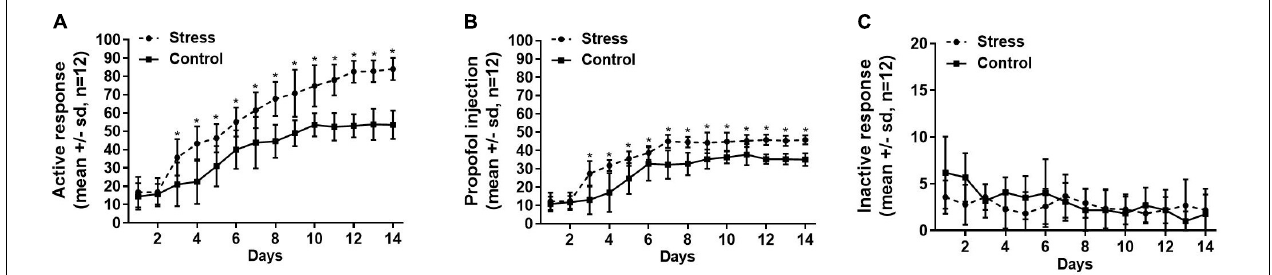
FIGURE 1 | The numbers of active nose-poke responses (A) , propofol infusions (B) , and inactive nose-poke responses (C) were compared between the stress group (with tail clip pretreatment) and the control group (without tail clip pretreatment) by using the two-way ANOVA of repeated measures, showing that the active nose-poke responses and propofol infusions were higher in the stress group than the control group (active nose-poke response p < 0.001, infusion p < 0.001, n = 12), and the number of inactive nose-poke response was not significantly different in both groups ( p = 0.16). SD, standard deviation, * p <